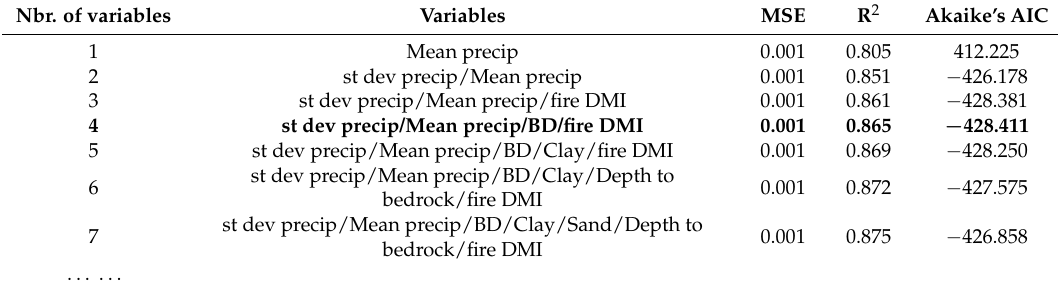
Table A1. Summary table of the variables selected, based on the least square method, for each multivariate linear model with the multi-year mean FAPAR as the response variable and the multi-year mean precipitation plus one up to 12 other site-specific variables. The “best” model was selected based on the AIC.